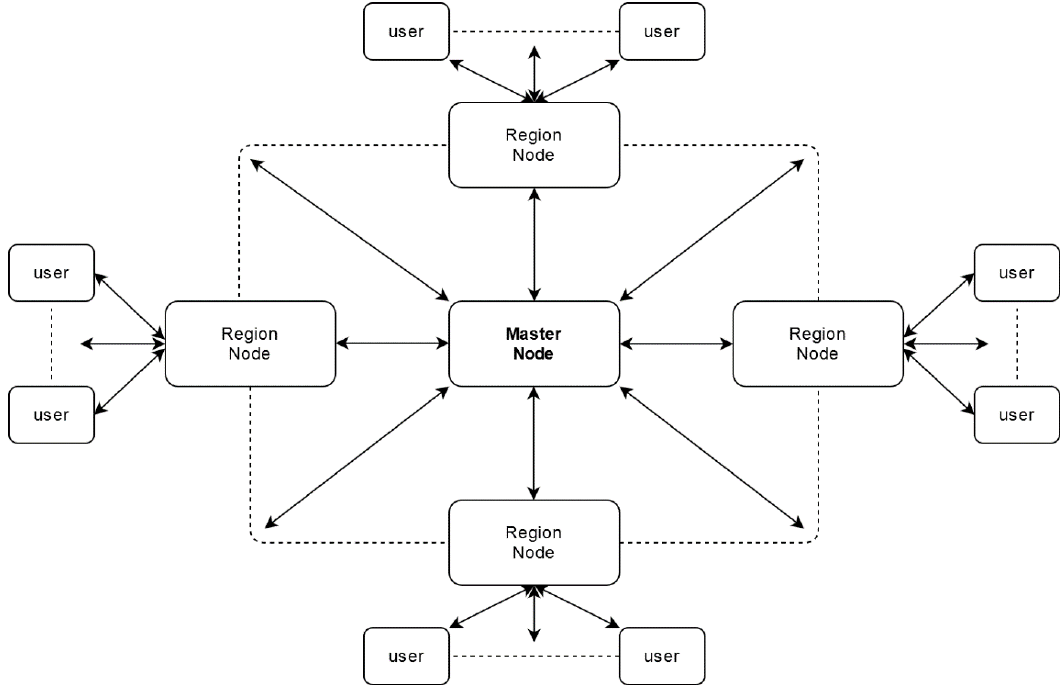
Figure 2. System design of the proposed